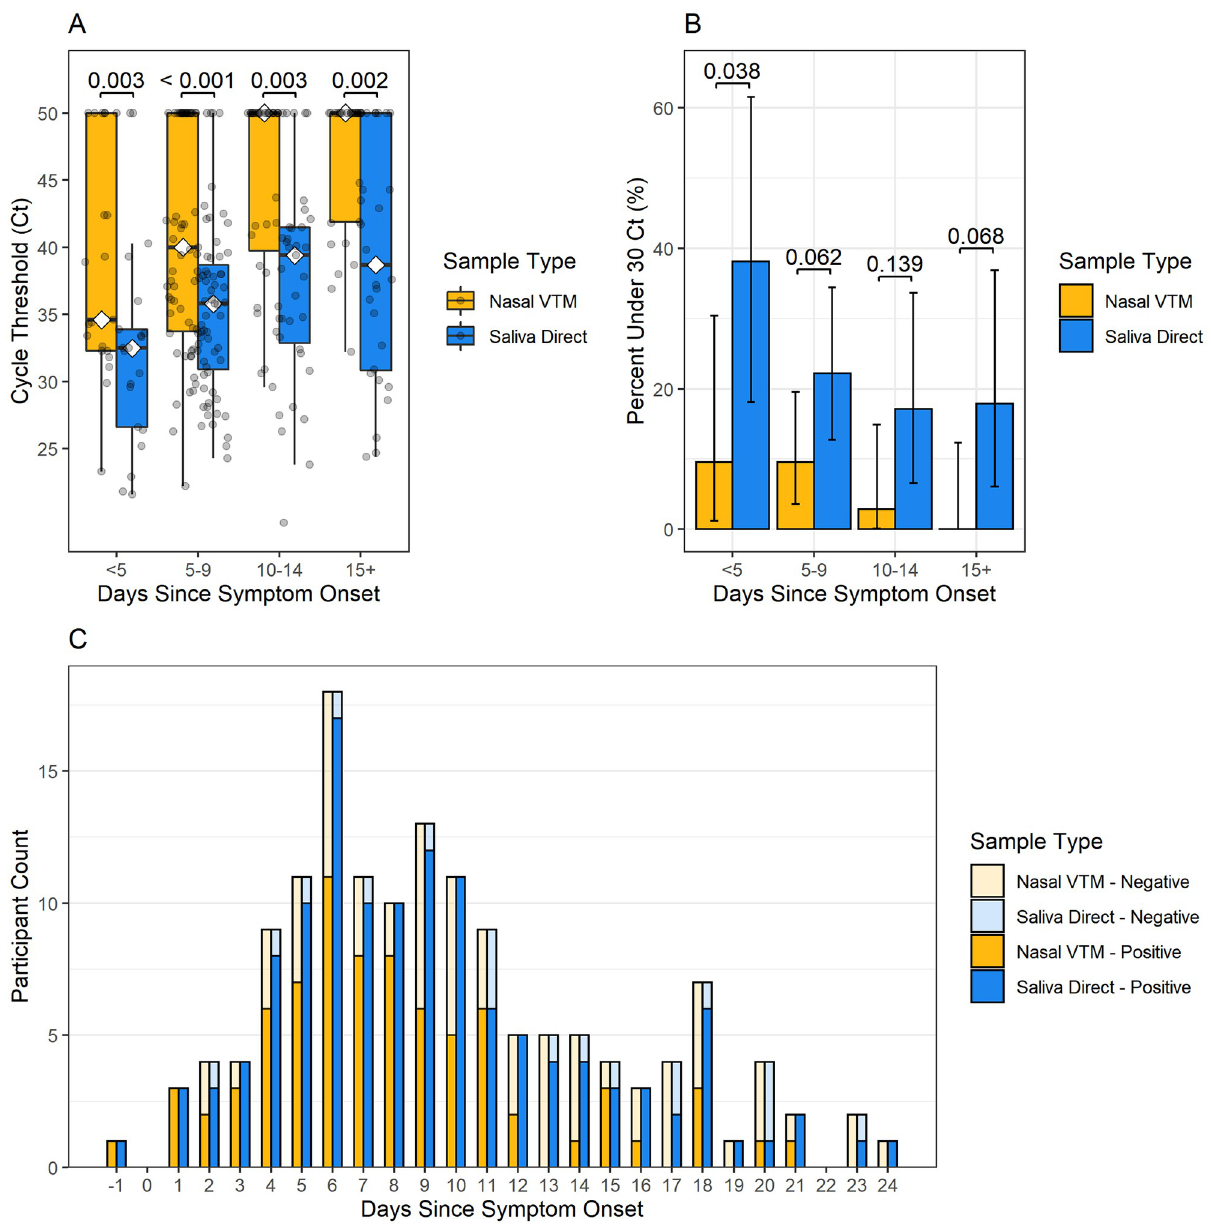
Fig 2. SARS-CoV-2 longevity in overall analysis cohort saliva and nasal specimens. (A) Ct values, (B) percent of Ct values under 30 and (C) number of positive and negative test results for saliva direct and nasal VTM specimens over days from symptom onset for the overall cohort (N = 96).